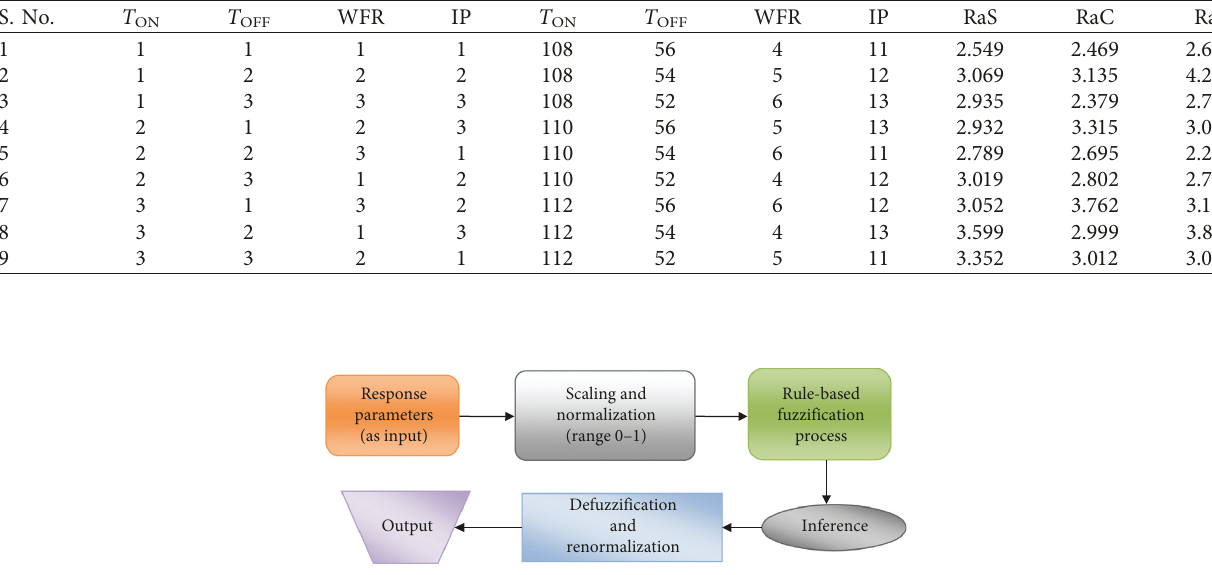
Figure 7: Elements of fuzzy interface